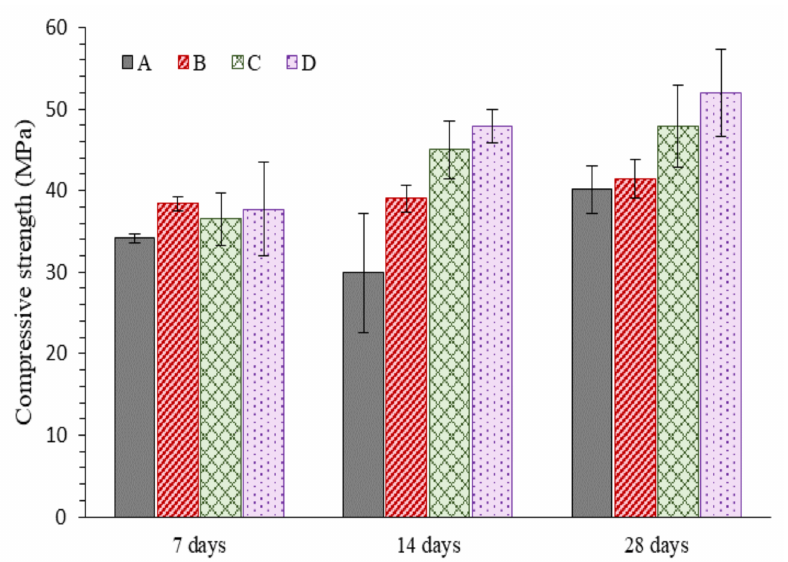
Figure 3. Compressive strength values of paste specimens after 7, 14, and 28 days of curing (A and B specimens: without and with bacterial culture solution in water curing, respectively. C and D specimens: without and with bacterial culture solution in carbonation condition,